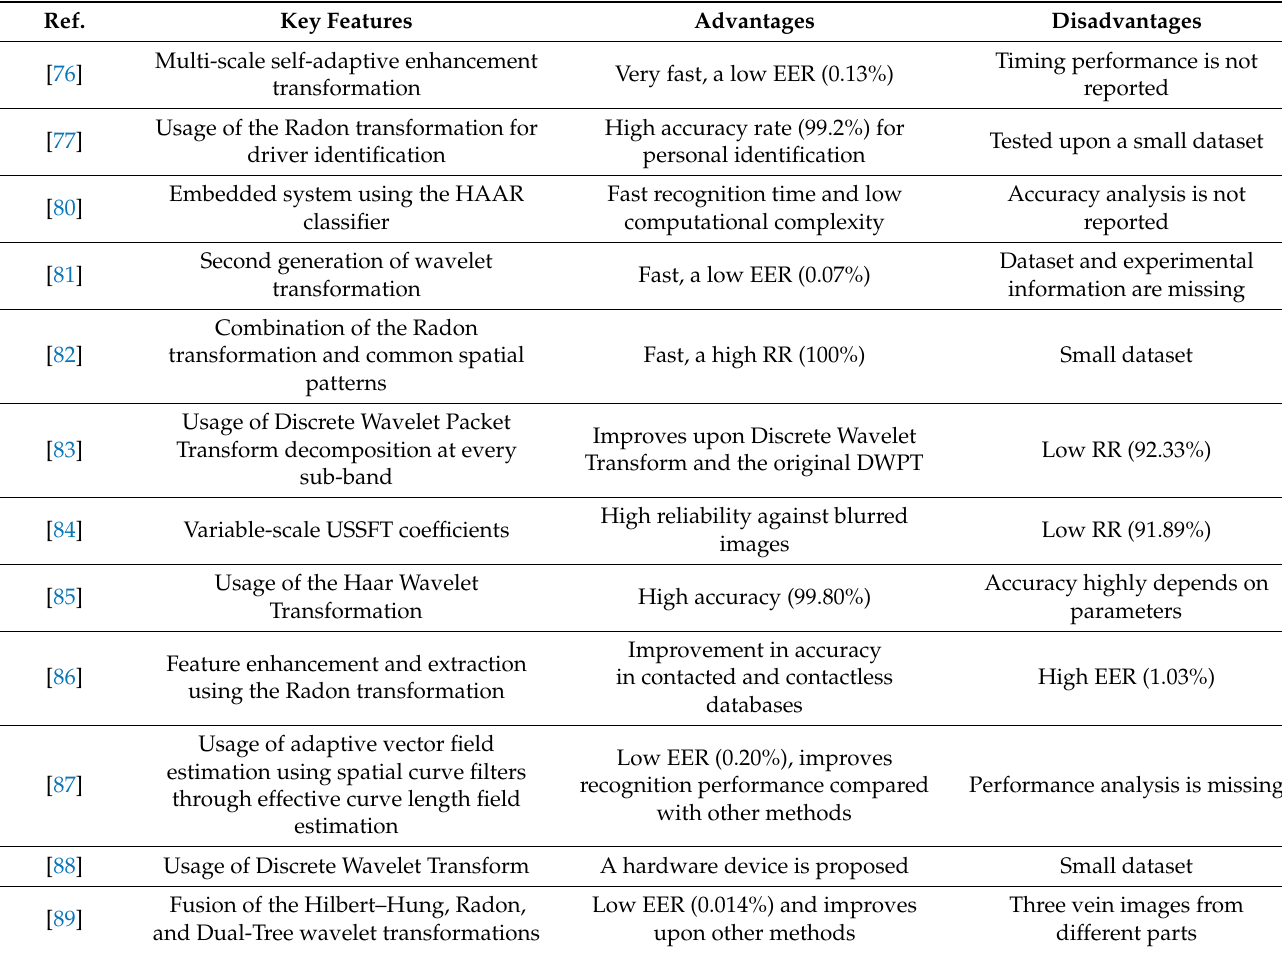
Table 4. Characteristics of the image-transformation-based feature extraction methodologies.